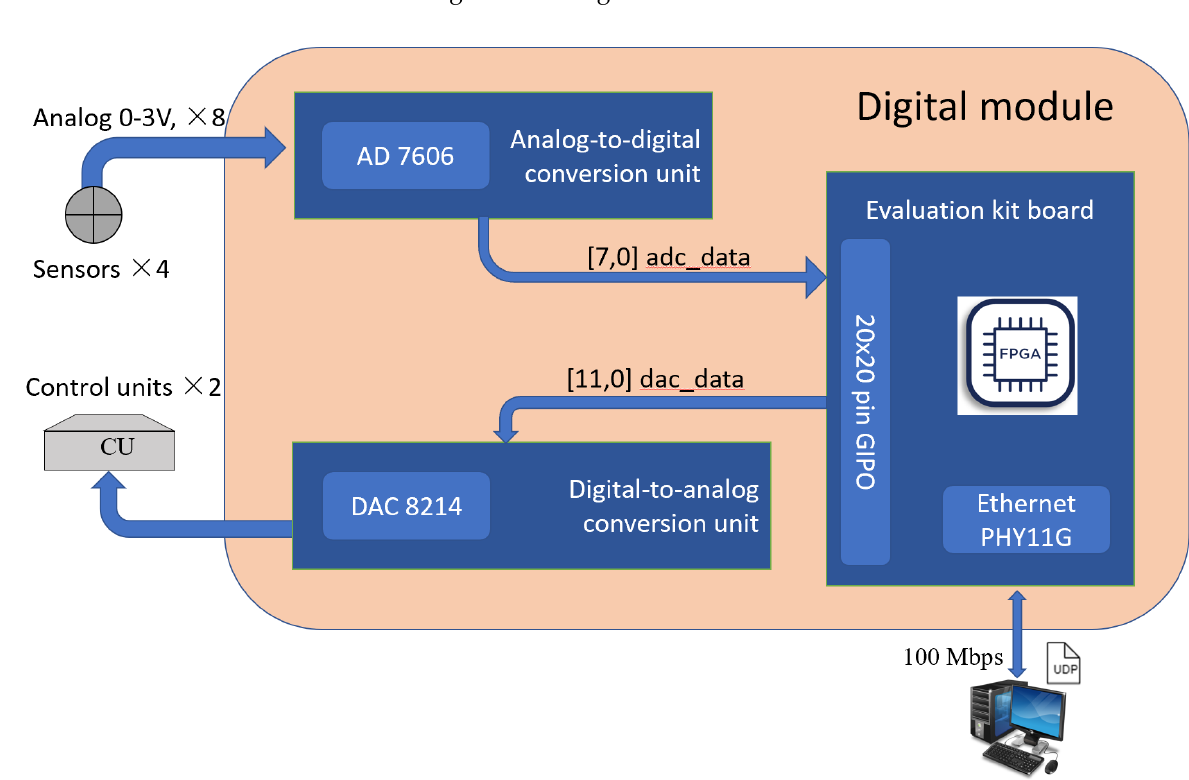
Figure 8. Scheme of the digital